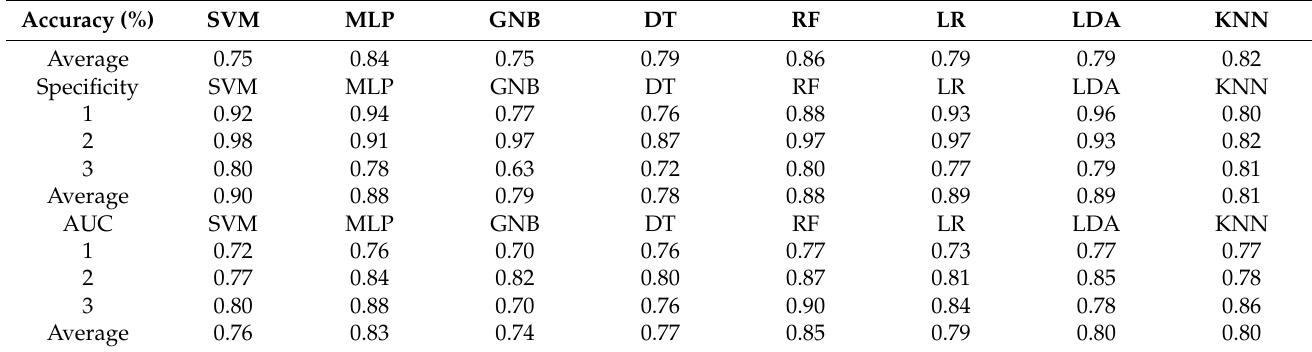
Table 3. Results of the leave-one-subject-out analysis for discriminating BPW indices between Data